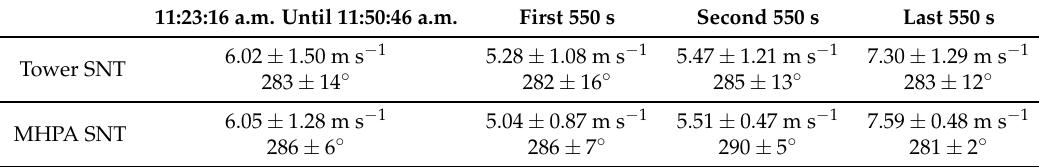
Table 3. Horizontal wind speed and wind direction at Schnittlingen meteorological tower. Data at 98 m AGL in comparison with the MHPA for the flight on 7 May 2015 between 11:23:16 p.m. and 11:50:46 p.m. local time. Additionally, the data is divided into three intervals of 550 s